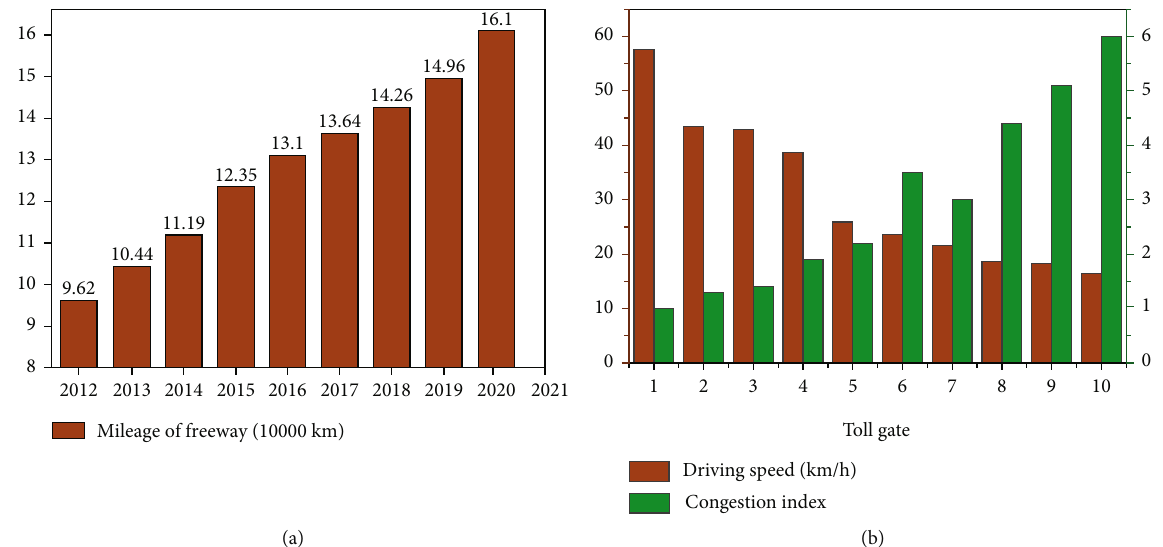
Figure 1: (a) Mileage of freeways in China. (b) Top 10 toll-gates ranked by congestion index (11 :10 April 9, 2022). (Data source from reference: